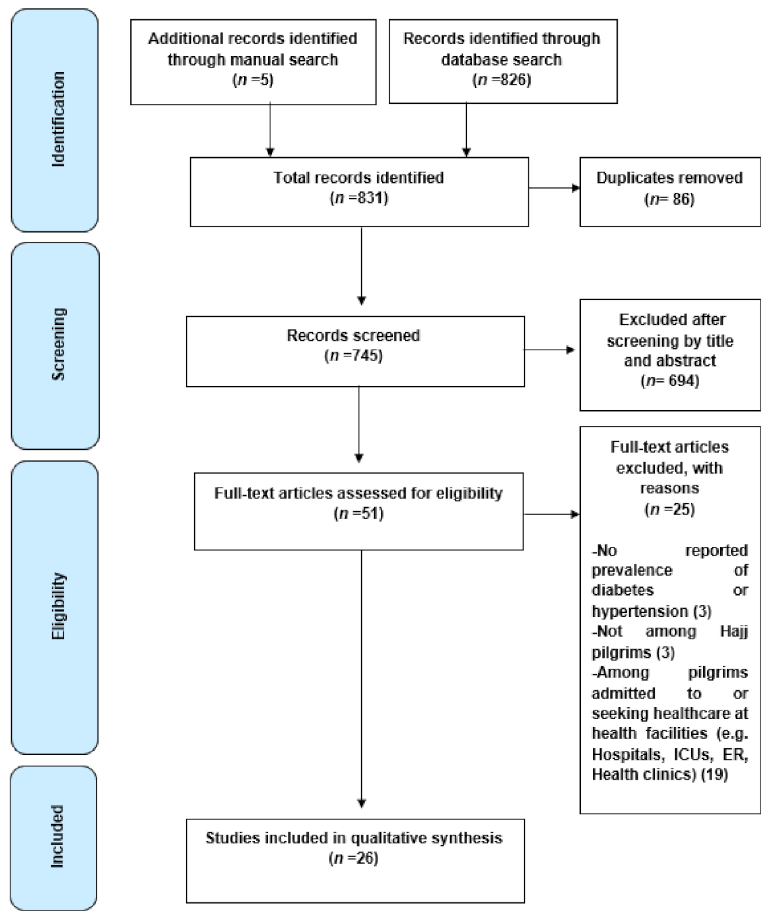
Figure 1. Preferred Reporting Items for Systematic Reviews and Meta-Analyses (PRISMA) study selection flow